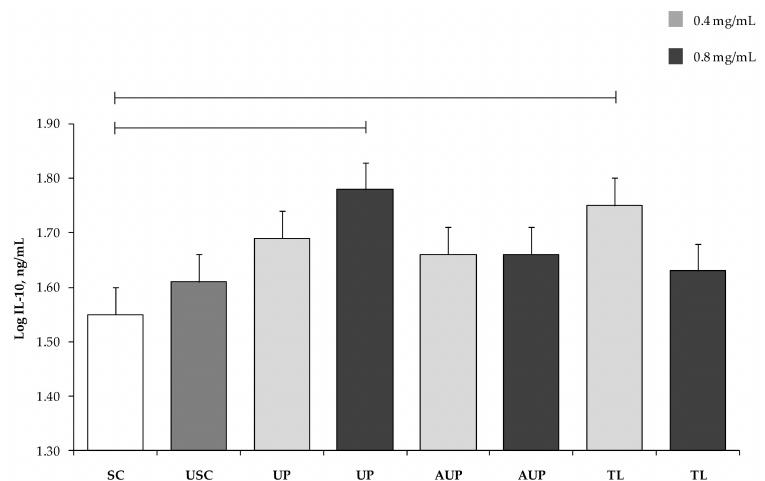
Figure 4. Interleukin (IL)-10 secretion by PBMCs stimulated with ConA and LPS and cultured with the unsaponified fraction (UP), the acetylated unsaponified fraction (AUP), and the total lipids fraction (TL) extracted and purified from C. sorokiniana . For each treatment, 0.4 mg/mL and 0.8 mg/mL were tested on PBMCs. PBMCs with ConA and LPS were stimulated cells (SC), and PBMCs without ConA and LPS were unstimulated cells (USC). Data were analyzed by one-way ANOVA and Fisher post-hoc test and are presented as least squares mean ± SEM. Bars indicate p <